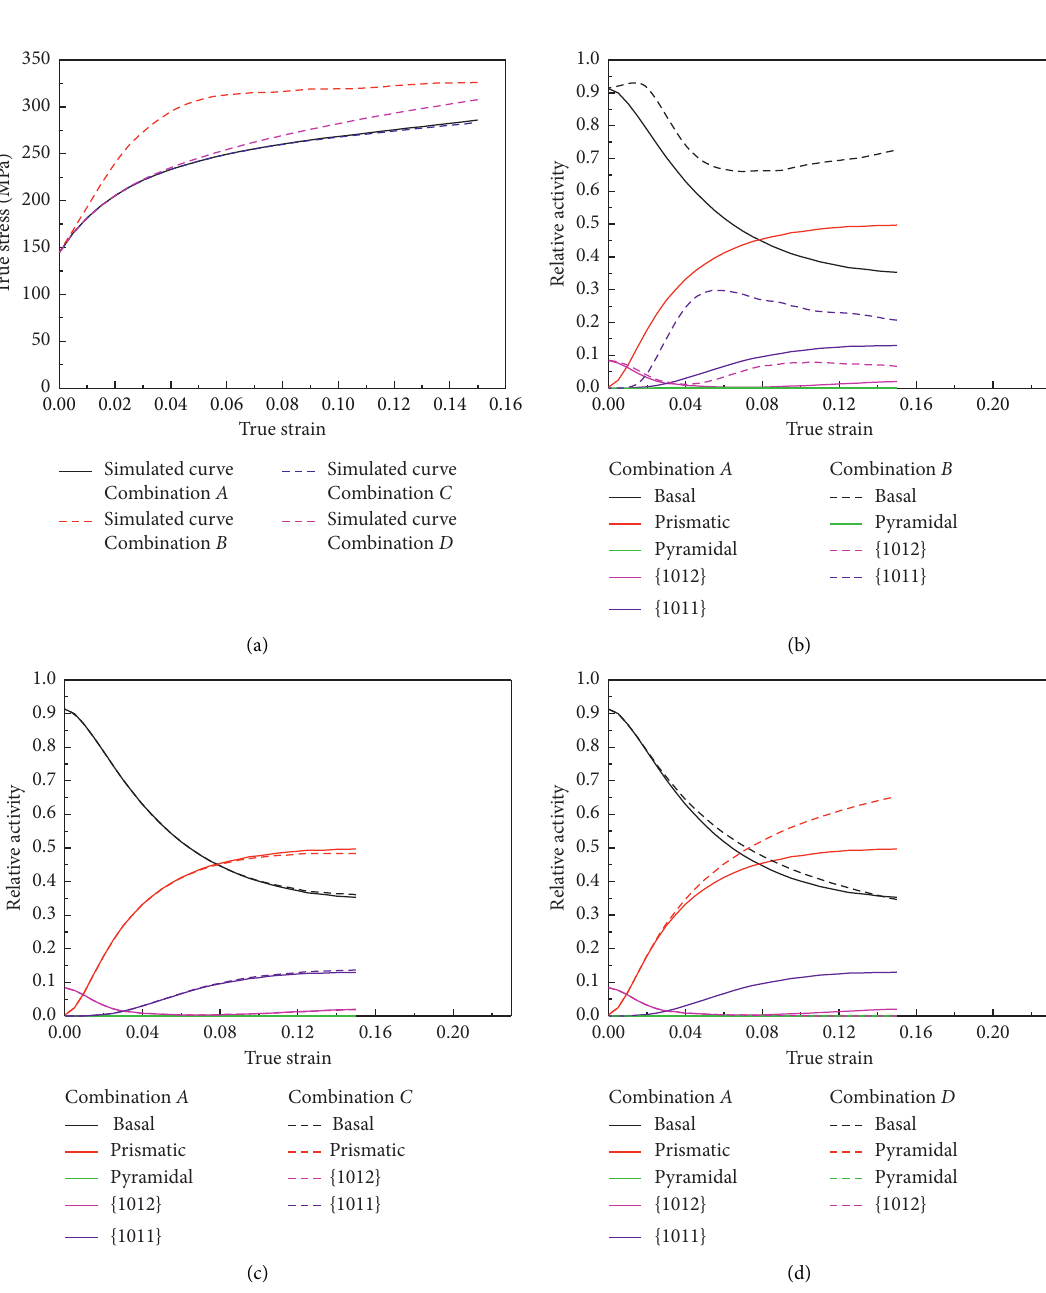
Figure 6: (a) Predicted stress–strain curves of AZ31 magnesium alloy under axial compression; (b–d) corresponding slip and twinning activities predicted by the VPSC model in the cases of combinations B, C, and D